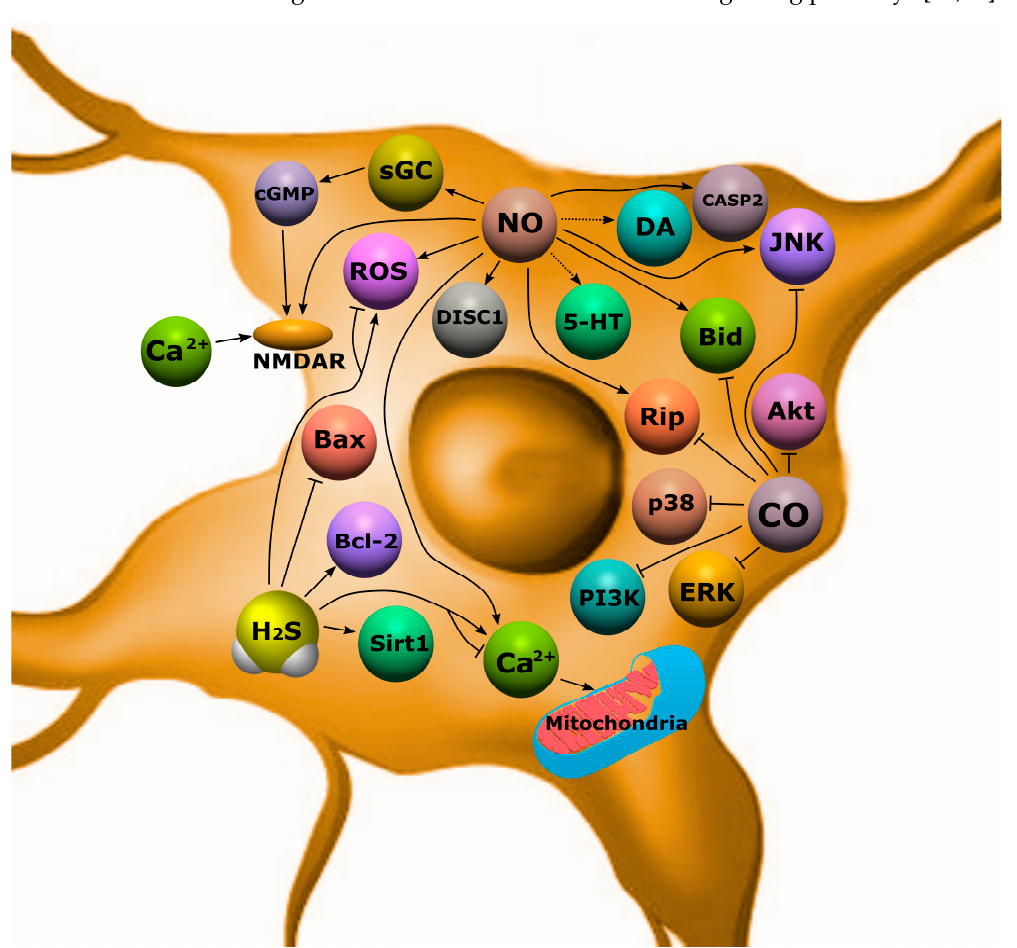
Figure 11. Possible gasotransmitter-dependent signaling mechanisms regulating apoptosis in mental disorders. NO, nitric oxide; CO, carbon monoxide; H 2 S, hydrogen sulfide; ROS, reactive oxygen species; CASP2, cysteine-aspartic acid protease 2; Bax, bcl-2-like protein 4; DA, dopamine; 5-HT, serotonin; sGC, soluble guanylyl cyclase; cGMP, cyclic guanosine monophosphate; p38, mitogen-activated protein kinase p38; JNK, c-Jun N-terminal kinases; Bid, BH3 interacting-domain death agonist; Rip, ribosome-inactivating protein; Akt, protein kinase B; ERK, extracellular signal-regulated kinase; PI3K, phosphoinositide 3-kinases; Sirt1, NAD-dependent deacetylase sirtuin-1; Bcl-2, B-cell lymphoma 2; NMDAR, N-methyl-D-aspartate receptor; DISC1, disrupted in schizophrenia 1. Arrows with a sharp end—positive regulation; arrows with a blunt end—negative regulation; dashed arrows—modification/adjustment.